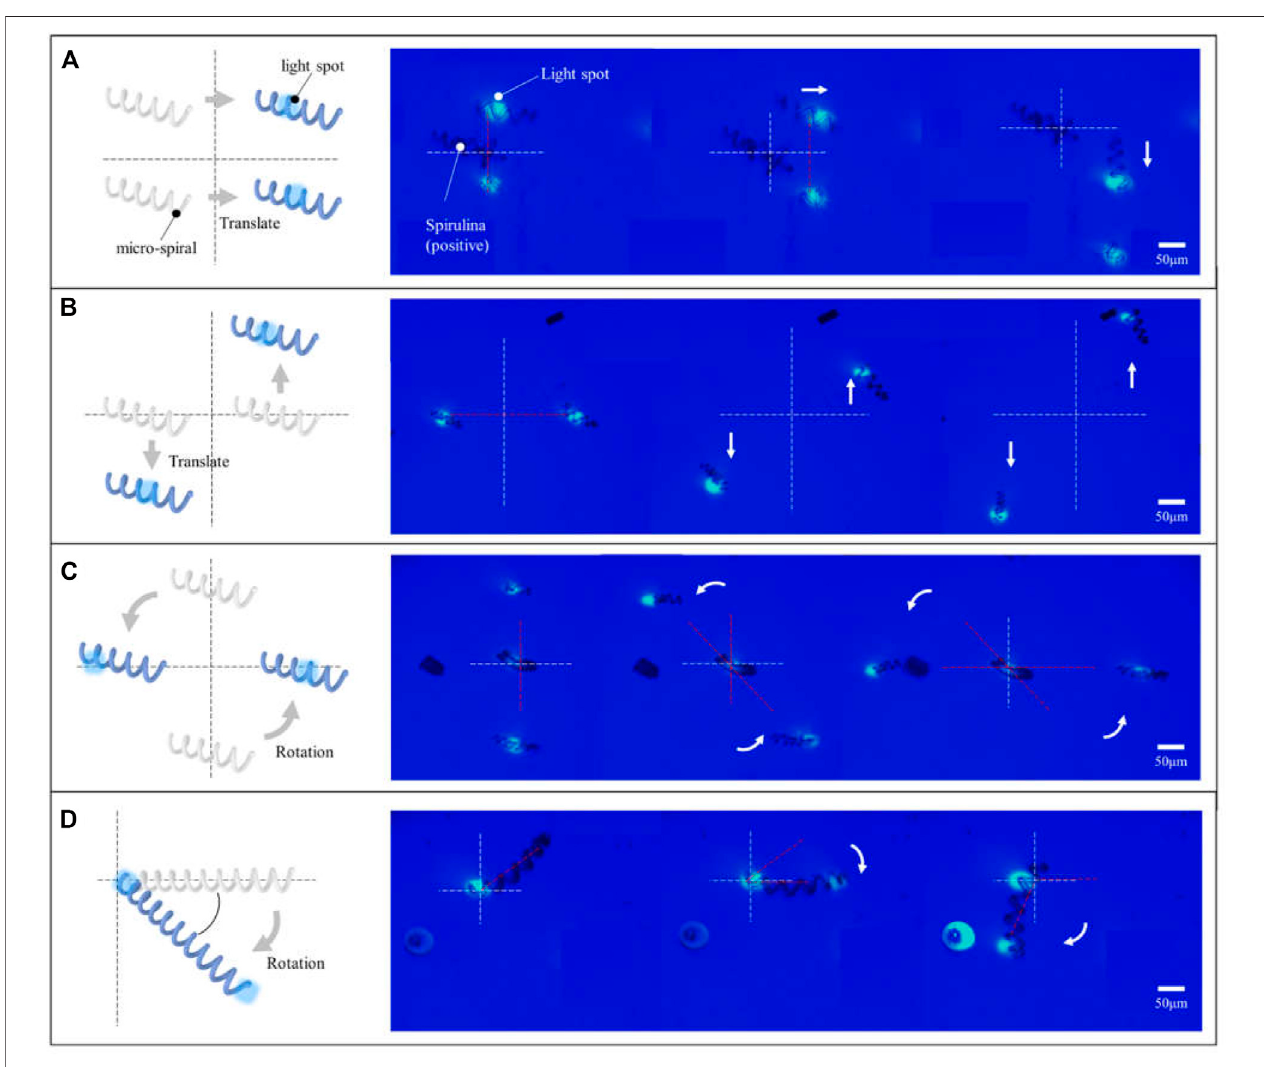
FIGURE 6 | Micro- spirulina were parallely manipulated by multiple light spots in the OET system. Translated in the (A) same direction and (B) opposite direction. Rotating along with (C) a point in the bottom electrode and (D) a point of itself.